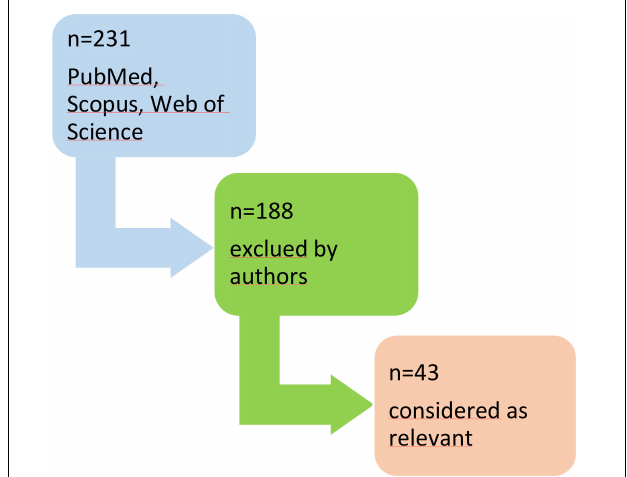
FIGURE 1 | The process of data collection.